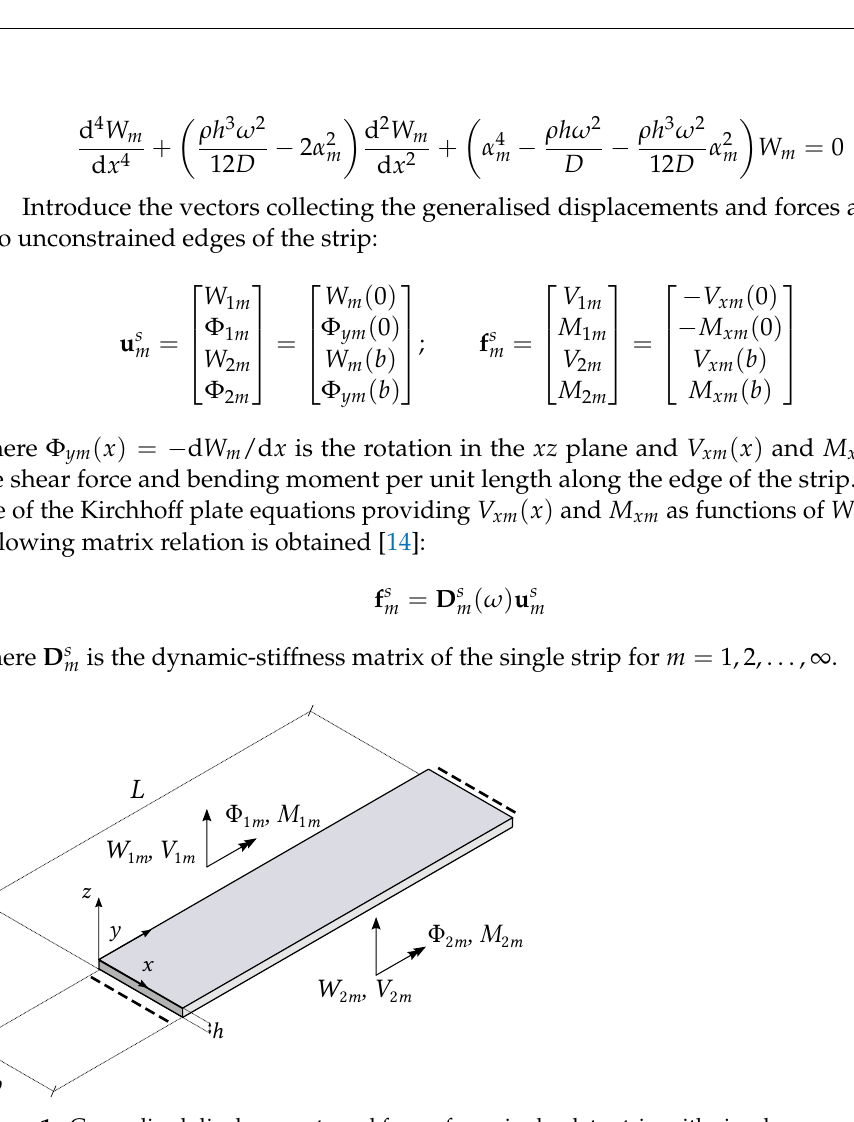
Figure 1. Generalised displacements and forces for a single plate strip with simply supported edges parallel with the x